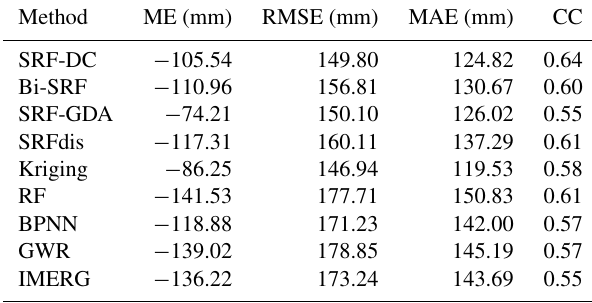
Table 2. Accuracy measures of all methods for estimating high pre- cipitation (i.e., values greater than